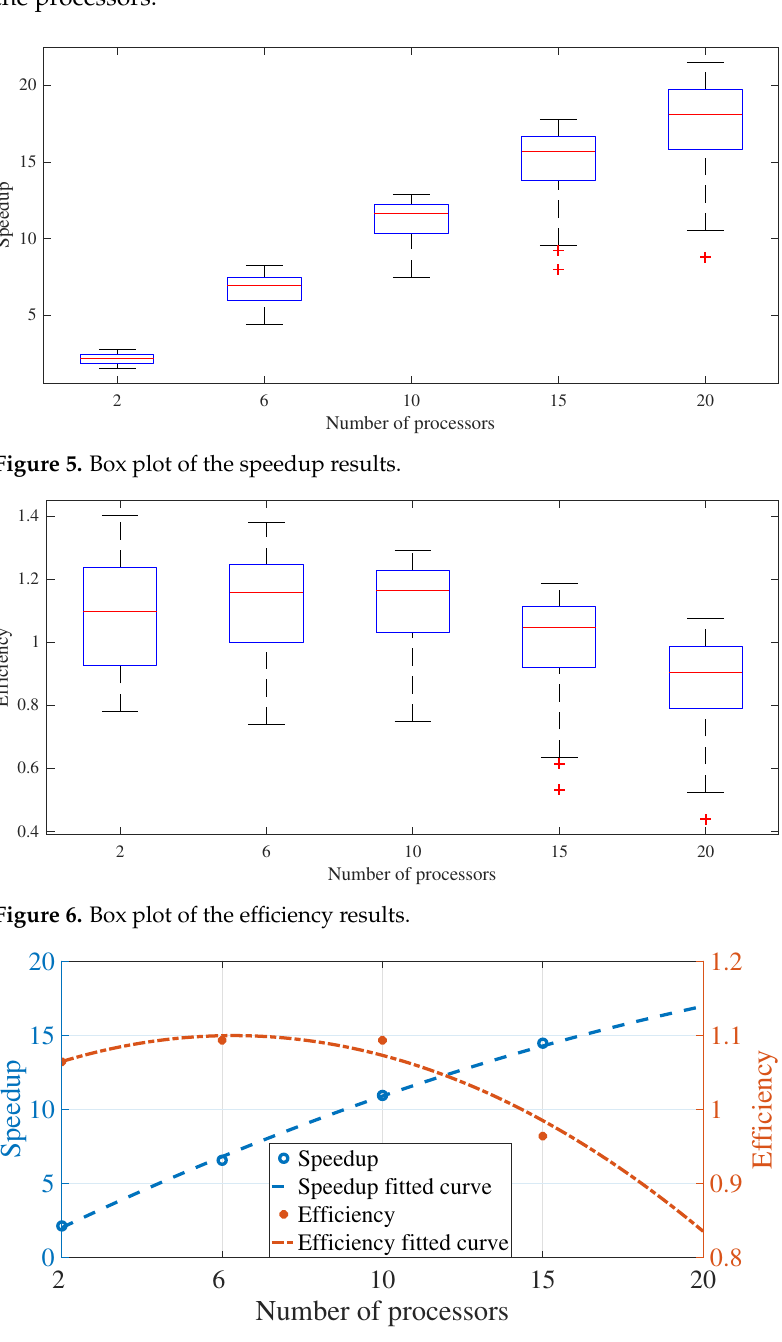
Figure 7. Speedup and efficiency versus number of